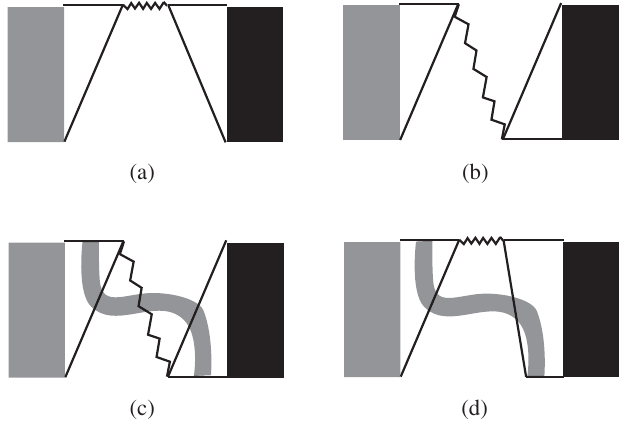
FIG. 7. Ladder insertions at O ð e 2 Þ , in addition to the ones shown in Fig. 5, that do not change the growth exponent λ . Diagrams (a) L and (b) have partner diagrams generated by reflection about the horizontal axis. Diagrams (c) and (d) have two partners each, from reflection about the horizontal and vertical axes. Other diagrams (not shown) similar to (c) and (d), with the internal resummed disorder linesterminating onthe sametimefoldinsteadofopposite time folds, vanish because of integrations over Green ’ s functions with poles on the same side of the real